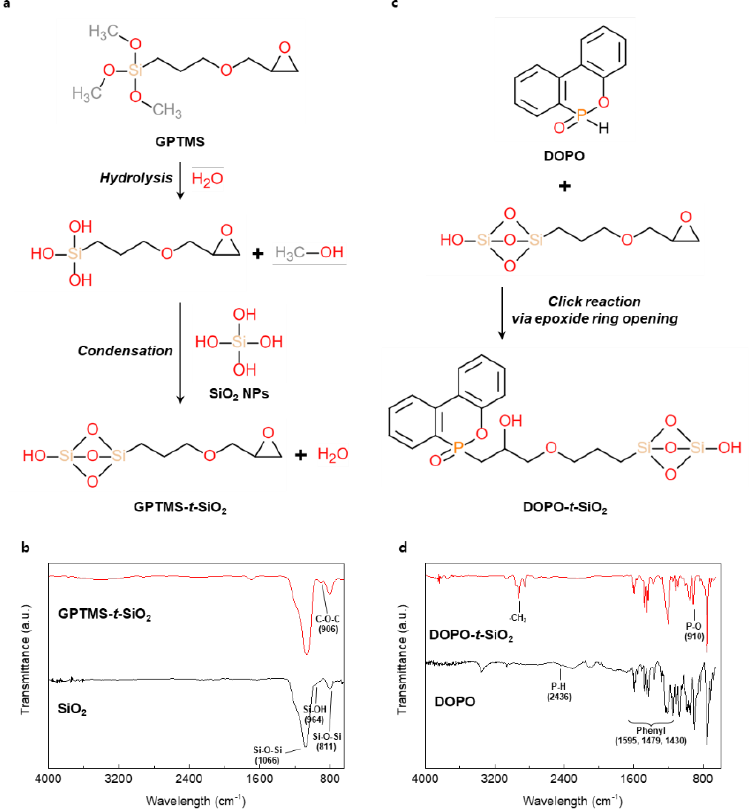
Figure 1. ( a ) Synthesis mechanism and ( b ) Fourier transform infrared (FTIR) spectra of GPTMS- t -SiO 2 . ( c ) synthesis mechanism and ( d ) FT-IR spectra of DOPO- t -SiO 2 .